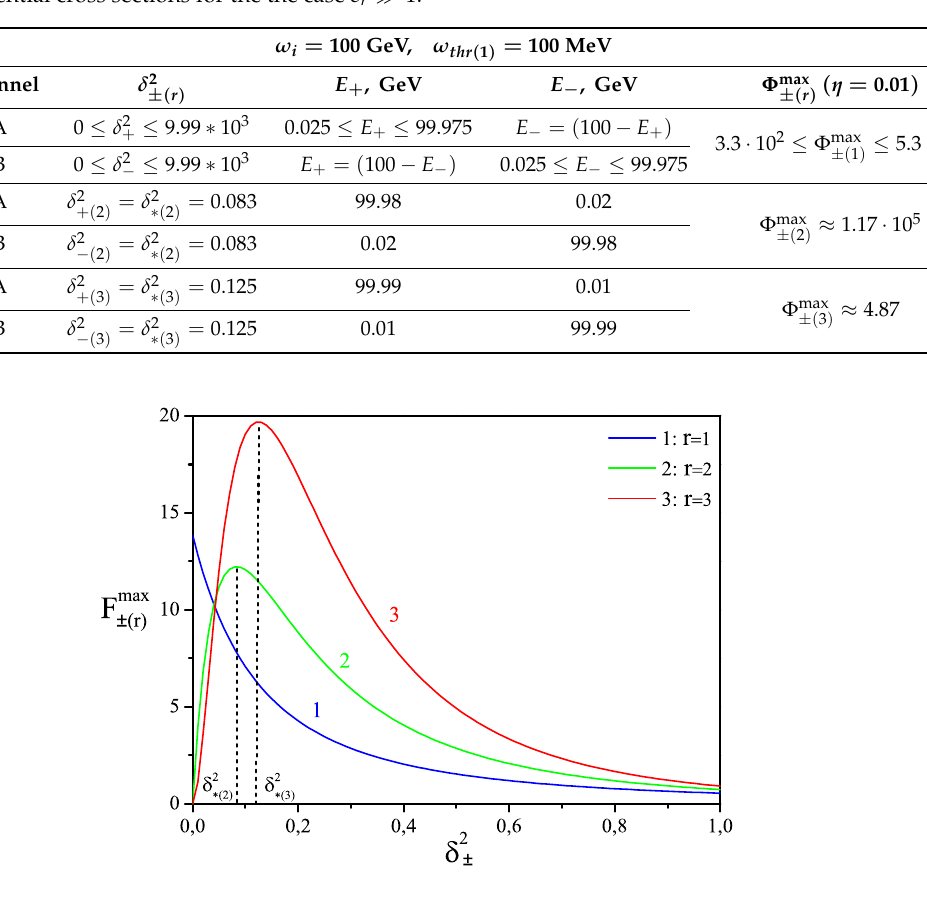
Figure 5. Dependences of the functions F max and for the case ε r (cid:29)